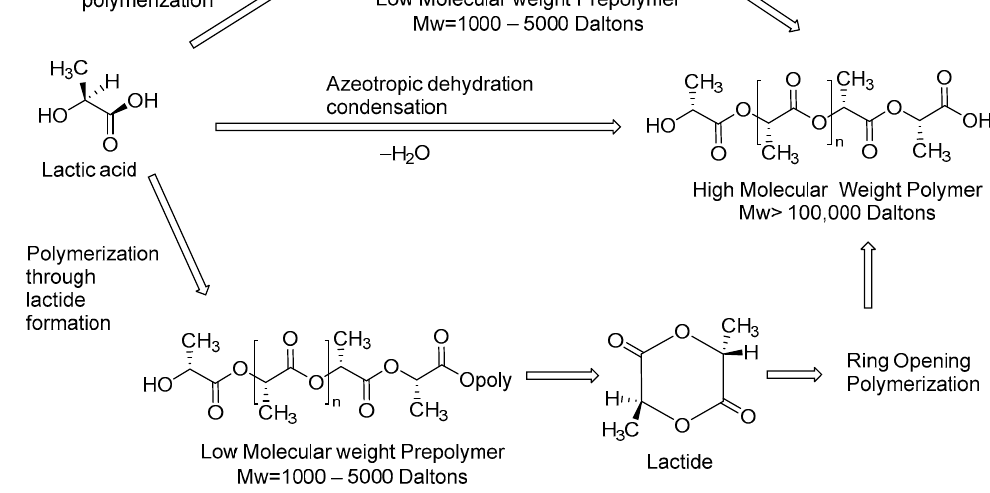
Figure 9. Synthesis of polylactic acid.